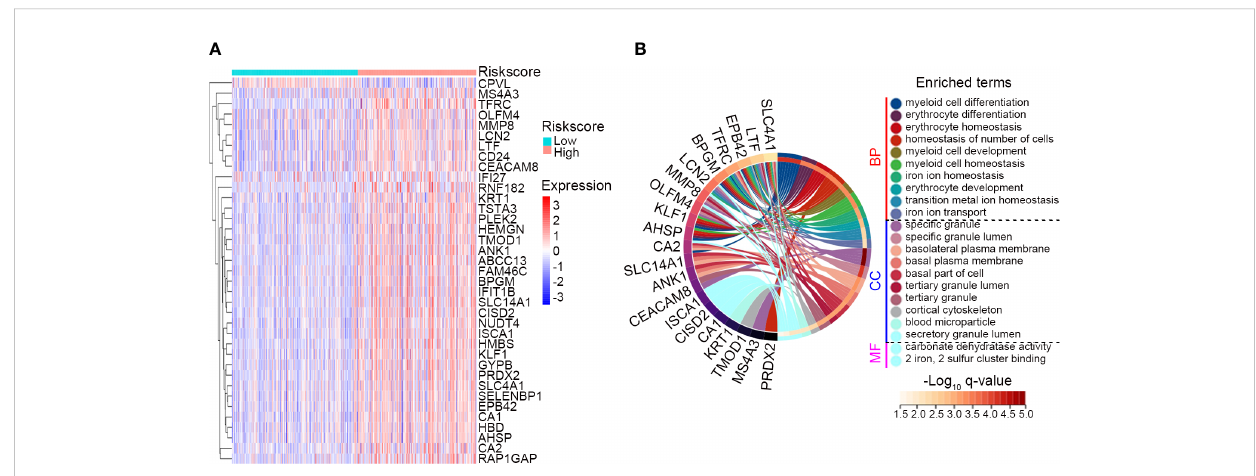
FIGURE 7 Assessment of biological pathways associated with the IRG signature. (A) The expression pro fi le of the DEGs between the low risk (n = 247) and high risk (n = 232) subgroups classi fi ed by the IRG signature in GSE65682. The screening criteria were set as adj. P-value < 0.05 and |Log 2 FC| ≥ 1. (B) GO analysis of the identi fi ed DEGs. Top 10 signi fi cant biological process (BP), top 10 signi fi cant cellular component (CC) and 2 signi fi cant molecular function (MF) of GO analysis were